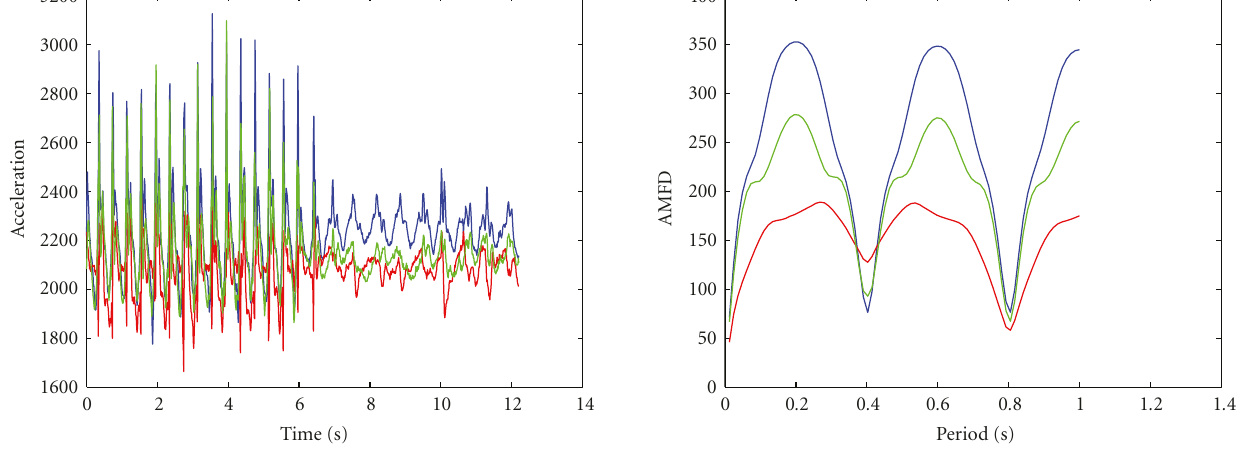
Figure 15: Raw accelerometer data of transition from running (left) to walking (right).